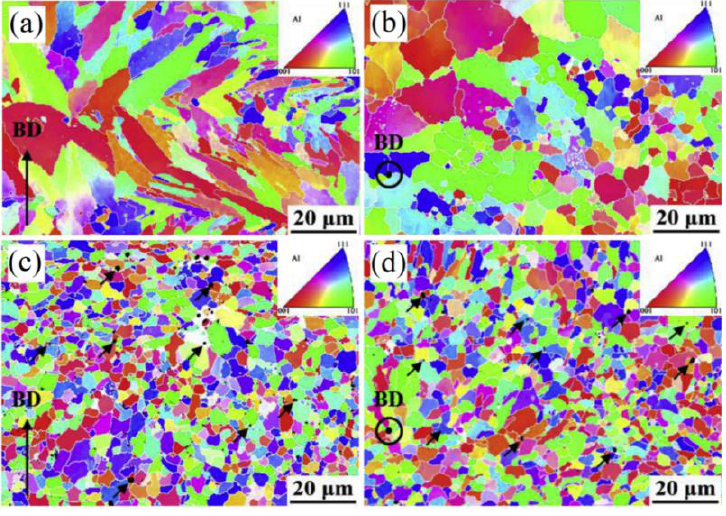
Figure 14. Electron backscattered diffraction (EBSD) inverse pole figure (IPF) maps of SLM-processed: Figure 14. TEM images of SLM-processed Al-coated graphene / AlSi10Mg composite: ( a ) before and ( b ) ( a ), ( b ) non-reinforced AlSi10Mg, and ( c ), ( d ) 3.4vol.%TiB2/AlSi10Mg composite. ( a ) and ( c ) are the after the deformation side-view while ( b ) and ( d ) are the top-view. The black arrows in ( d ) and ( e ) point to the TiB 2 reinforcing particles [72].